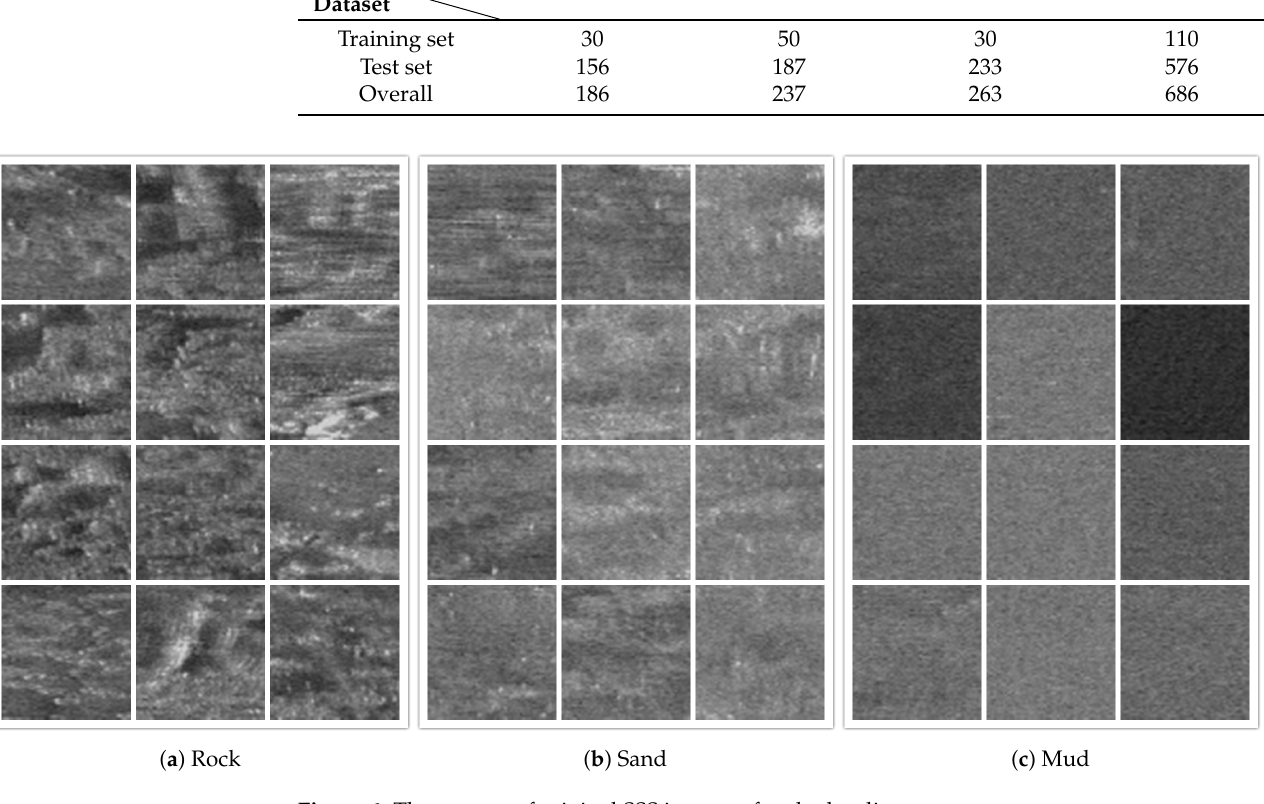
Figure 6. Three types of original SSS images of seabed sediments.